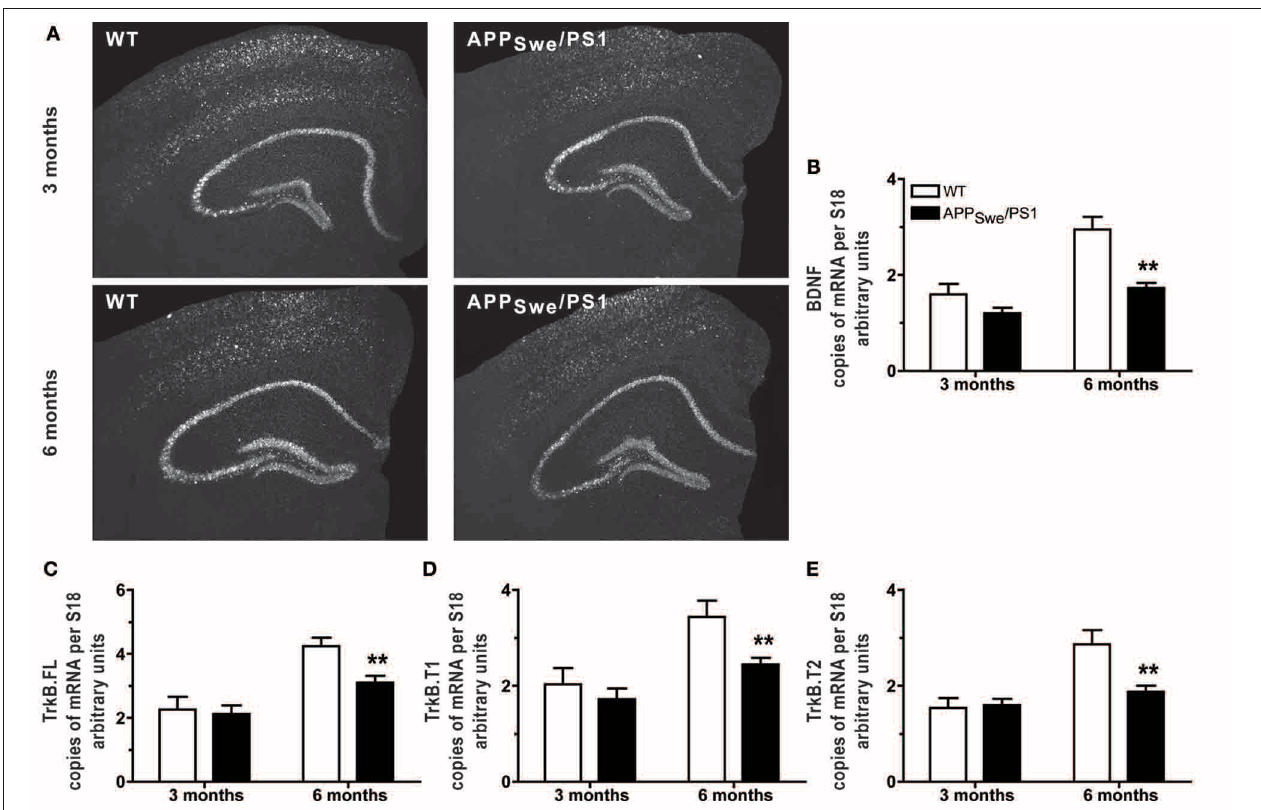
FIGURE 2 | Expression of BDNF and its receptors decreased in hippocampus when mnesic deficits begin in APP Swe /PS1 mice. Representative dark-field photomicrographs of in situ hybridization showed the hippocampal expression of BDNF mRNA (A) in the brain of 3- and 6-month-old WT and APP Swe /PS1 mice. For hippocampus, mRNA levels of BDNF and its receptors—TrkB.FL, TrkB.T1, and TrkB.T2—were determined by real-time qPCR and normalized relative to